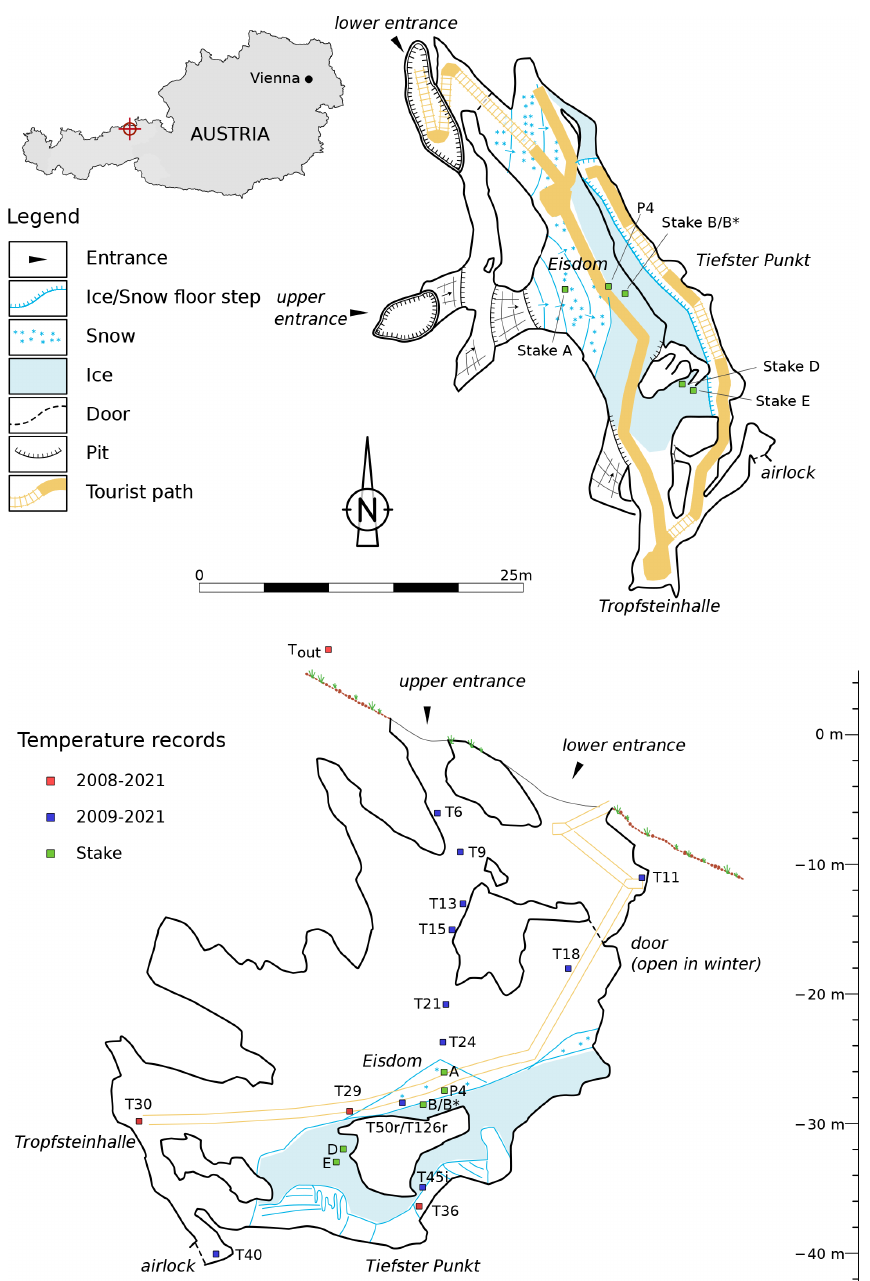
Figure 1. Plan view of HIC with stake locations (upper panel) and elevation view with temperature logger and stake locations (lower panel). The blue-coloured loggers captured only part of the measuring period, at various intervals between the years 2009 and 2021.